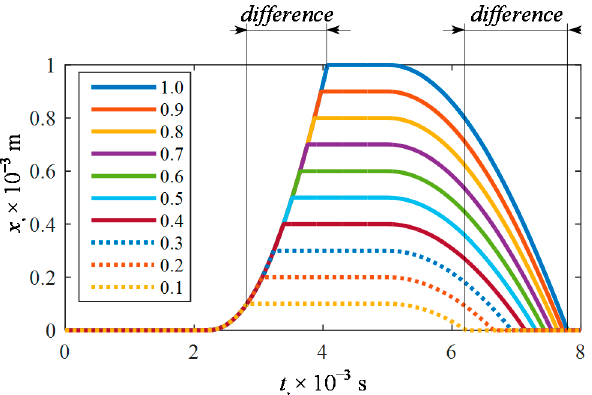
Figure 7. Variations of plunger displacement and acting forces were obtained by calculation at x max = 0.4 × 10 − 3 m.